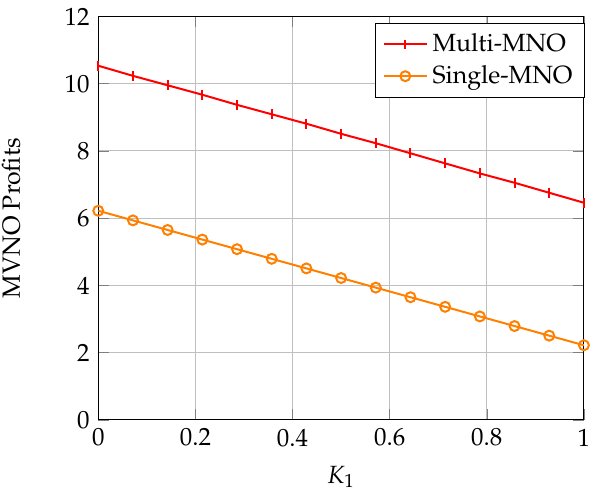
Figure 12. MVNO equilibrium profits as a function of K with K 2 =